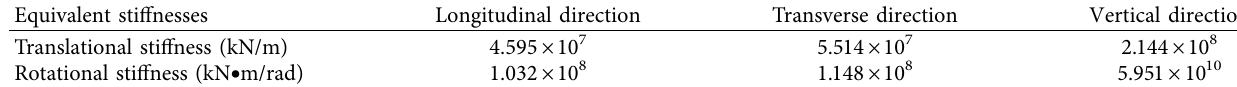
Table 2: Equivalent stiffness of pile foundations.